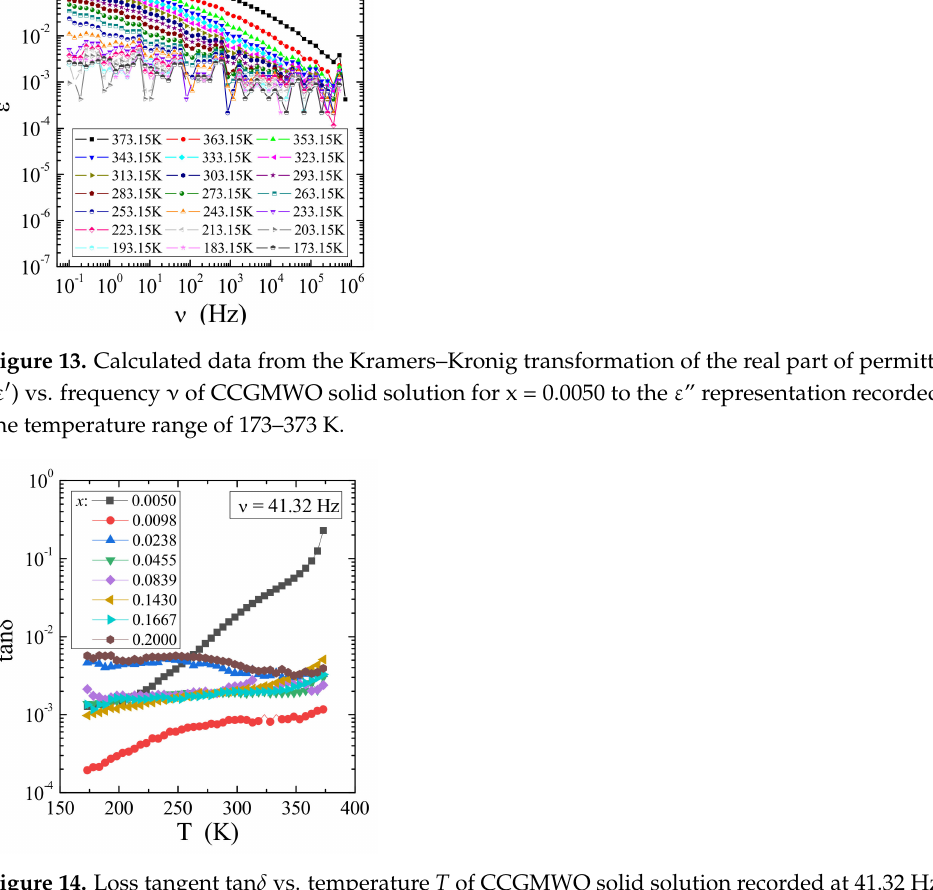
Figure 14. Loss tangent tan δ vs. temperature T of CCGMWO solid solution recorded at 41.32